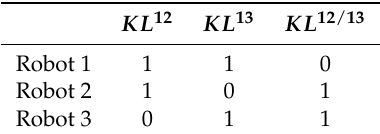
Table 5. The proposed signature matrix of robot